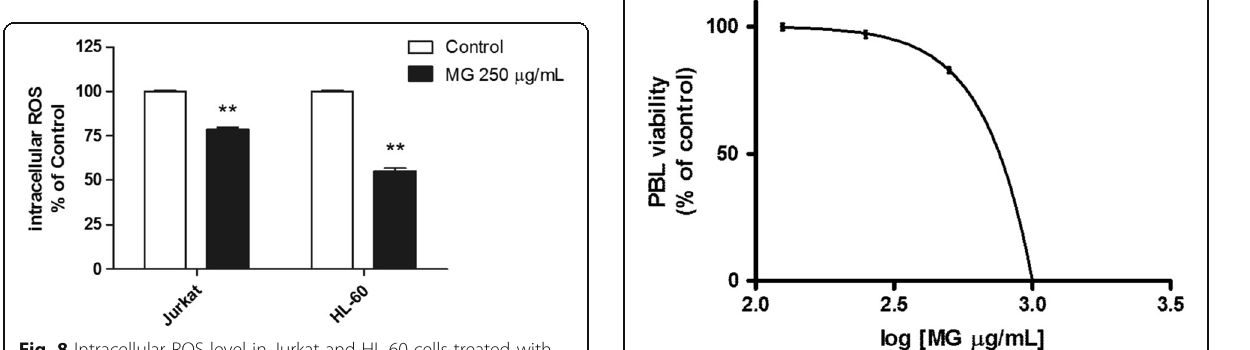
Fig. 8 Intracellular ROS level in Jurkat and HL-60 cells treated with MG at 250 μ g/mL for 24 h. Each bar represents the mean ± SEM of three independent experiments. Data were analysed by t-test, ** p < 0.01 vs control